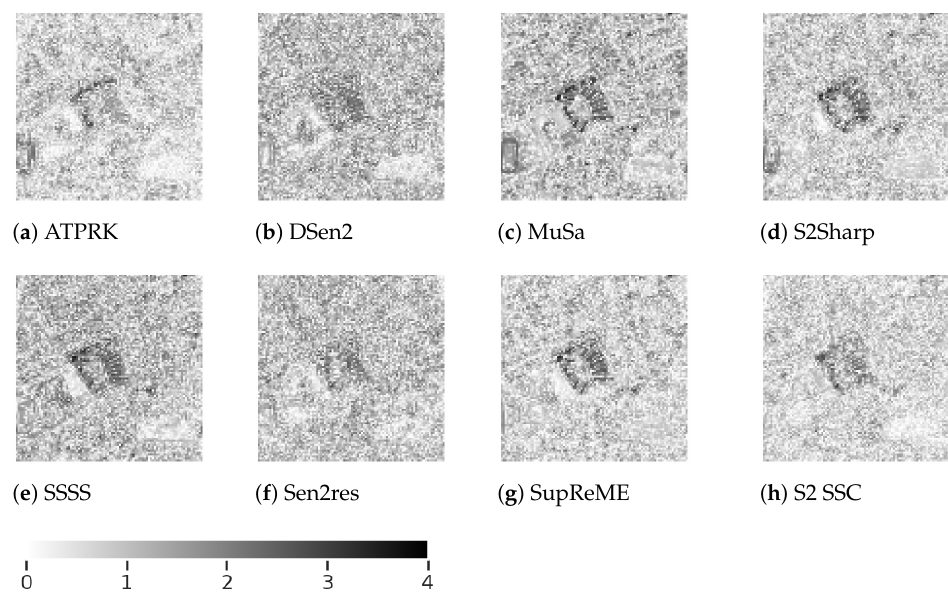
Figure 8. Absolute error map of Escondido crop, band B12, on log scale. Lower values are better.